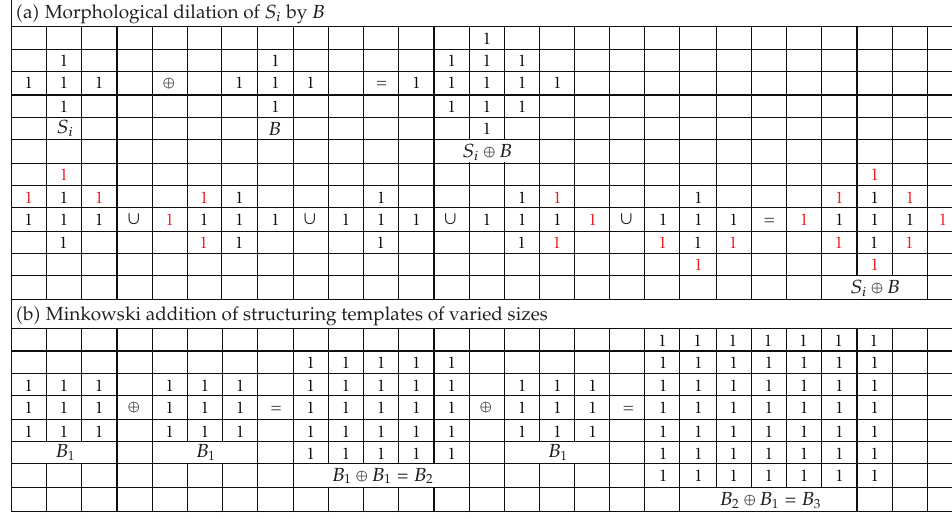
Figure 11: (cid:2) a (cid:3) Morphological dilation and involved translates, and (cid:2) b (cid:3) square structuring templates of varied sizes and their Minkowski